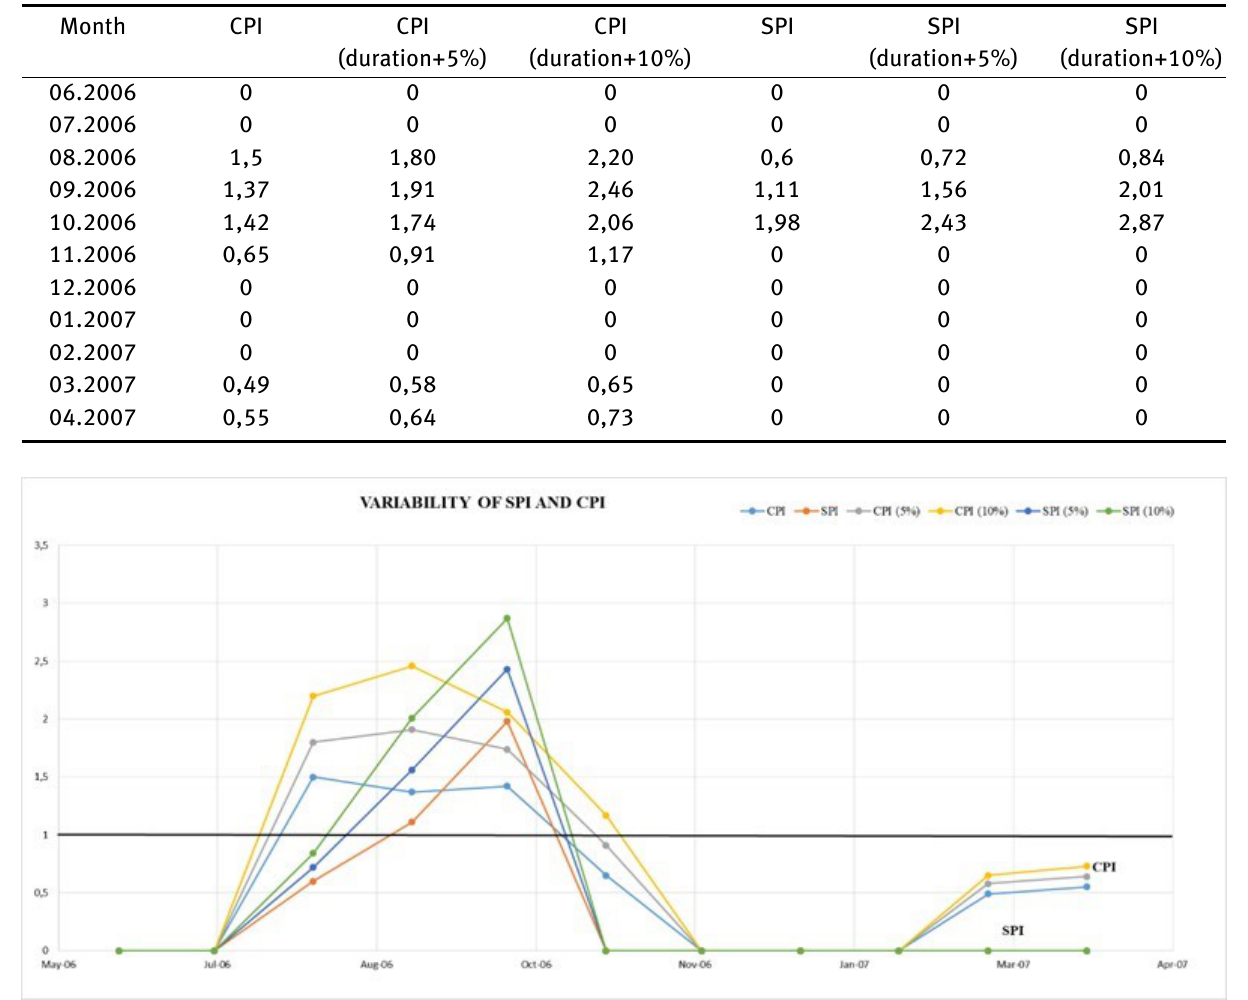
Figure 7: Variability of SPI and CPI [authors’ data]